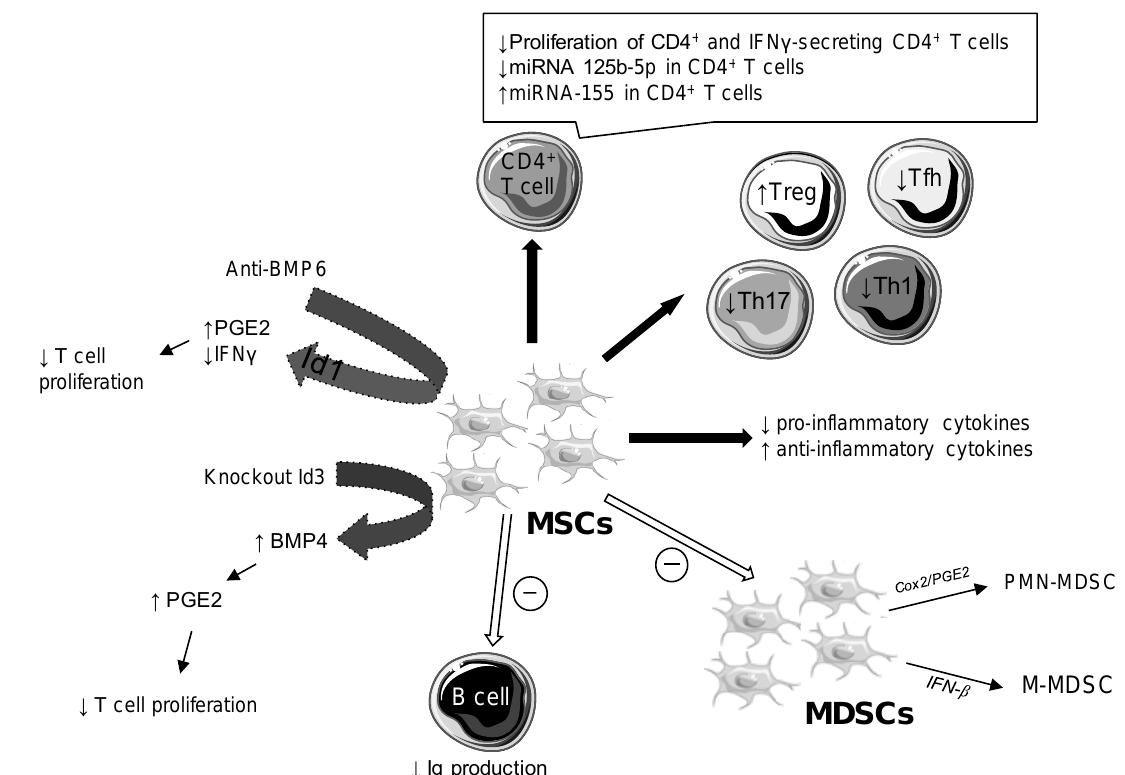
Figure 3. Cellular and molecular impacts of mesenchymal stem cells (MSCs) in Sjögren’s syndrome (SS) . Bone morphogenic protein (BMP), immunoglobulin (Ig), interferon (IFN), DNA binding protein inhibitor (Id), myeloid suppressor cells (MDSCs), polymorphonuclear (PMN)-MDSCs, monocytic MDSCs (M-MDSCs), regulatory T cell (Treg), helper T cell (Th), follicular helper T cell (Tfh), prostaglandin E2 (PGE2), cyclooxygenase (Cox).